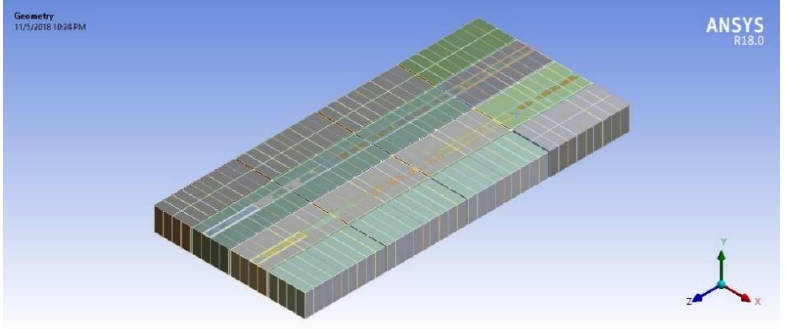
Figure 4. The configuration of the ferry composed of 16 pontoons.